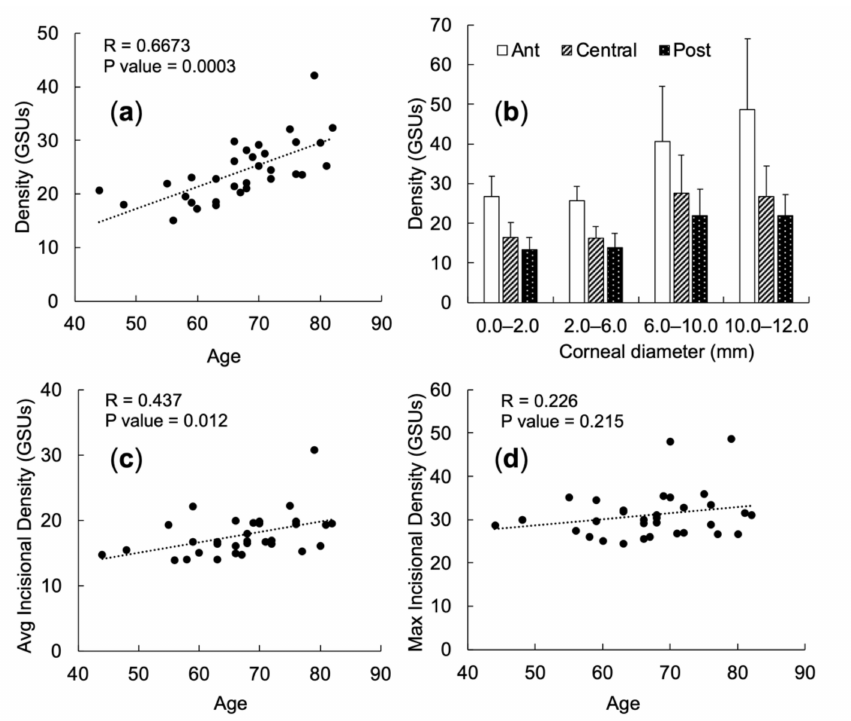
Figure 3. Preoperative corneal optical density of corneal diameter and incisional site. ( a ) The correlation between corneal optical density (COD) and age. ( b ) Comparing the CODs among the anterior, central stroma, and posterior layers of the cornea. ( c ) Correlation between age and average COD at the incisional site. ( d ) Correlation between age and maximal COD at the incisional site. Density = corneal optical density; GSUs = grayscale units; ant = the anterior layer of cornea (anterior 120 µ m); post = the posterior layer of cornea (posterior 60 µ m); central = the central stroma of cornea between ant and post.